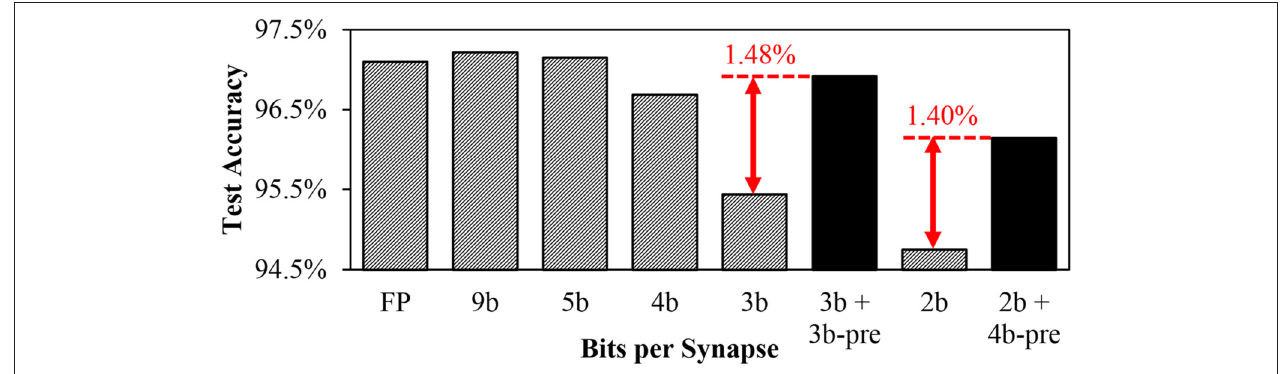
FIGURE 8 | MNIST inference accuracy using different numbers of bits per